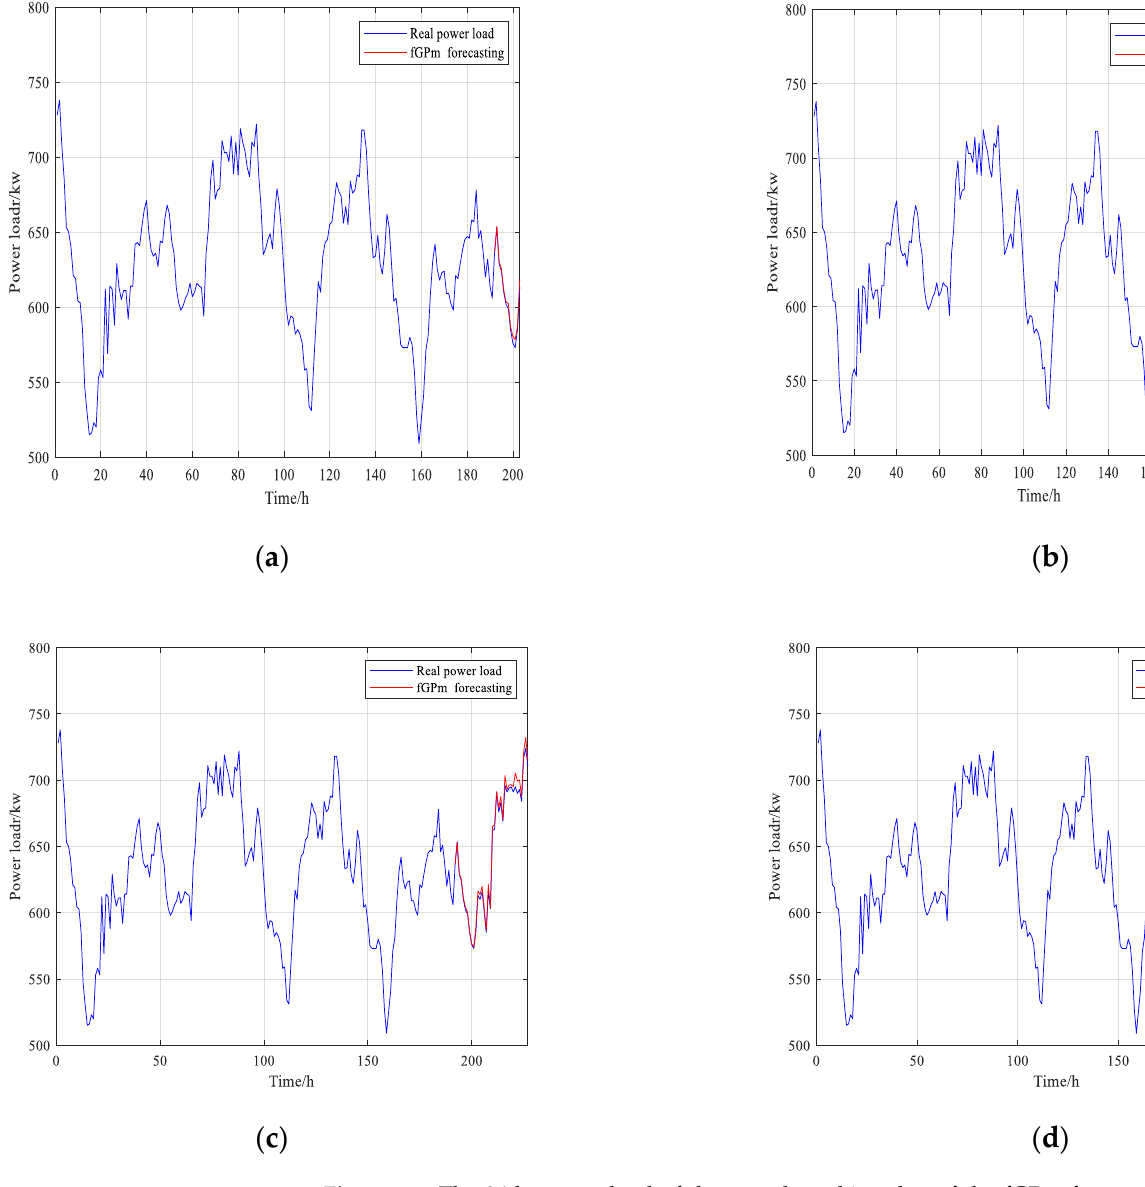
Figure 12. The 96-h power load of the actual working day of the fGPm forecast model and the subsequent forecast 24-h trend chart. ( a ) 6 h ( b ) 12 h ( c ) 18 h ( d ) 24 h.